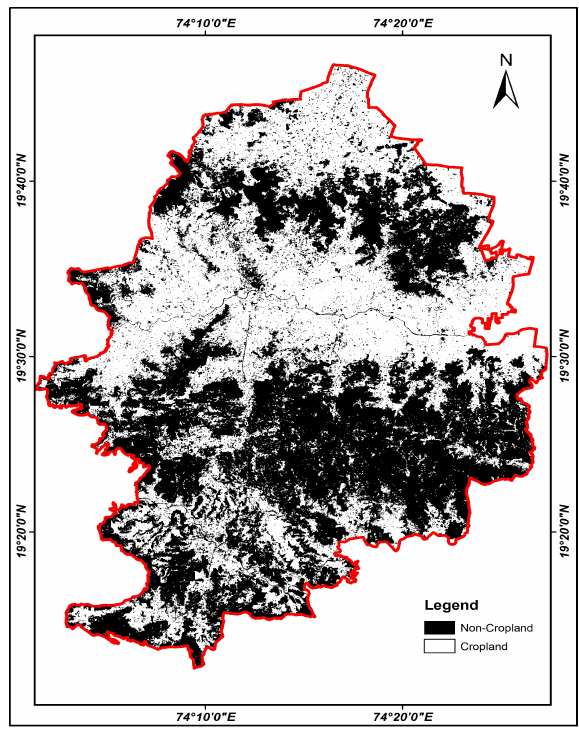
Figure 3. Crop mask created from S-2 series